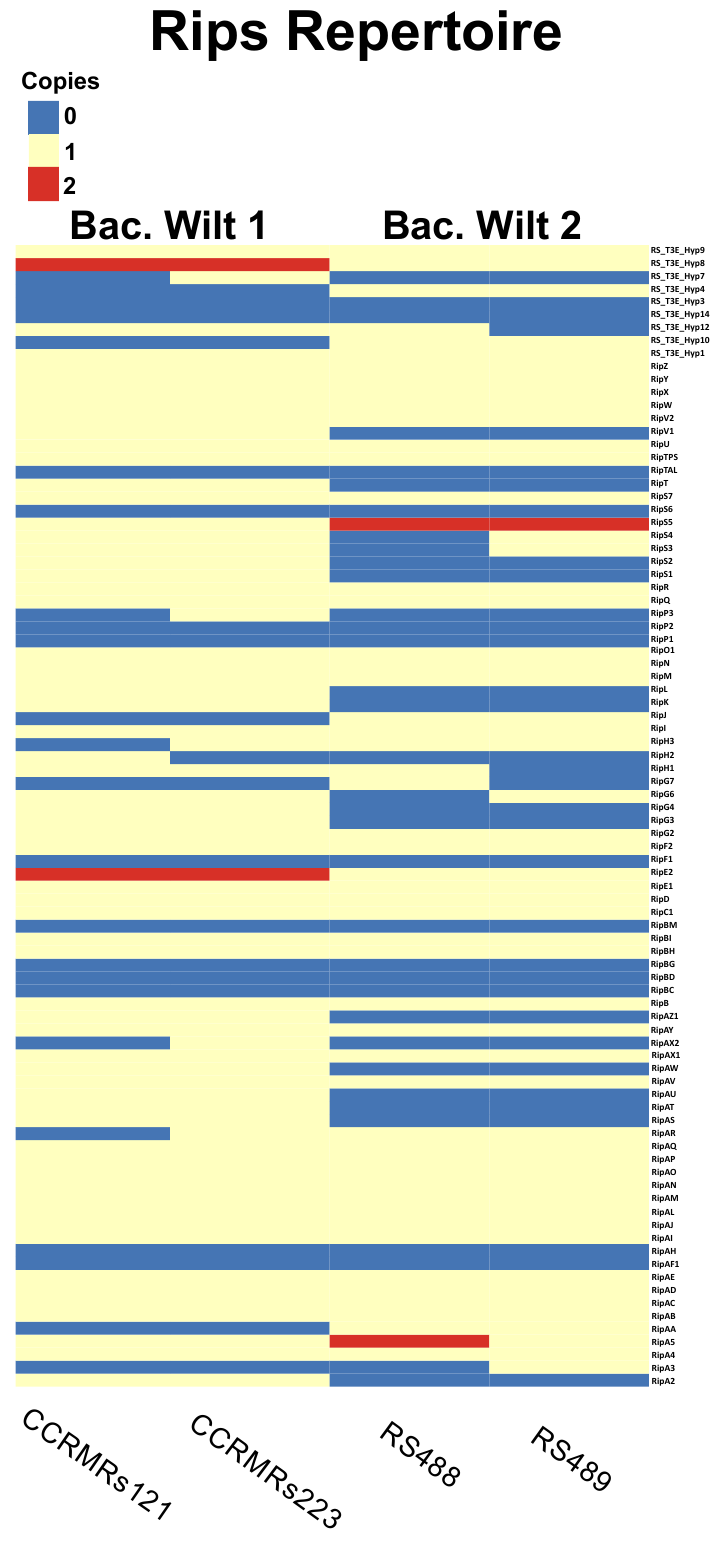
Figure A1. Heatmap of Rips repertoire of newly sequenced (Bac. Wilt 1) and publicly available (Bac. Wilt 2) genomes from isolates causing bacterial wilt in Brazil. The genomes on the right have notably fewer Rips than the newly sequenced ones, despite all causing diseases in